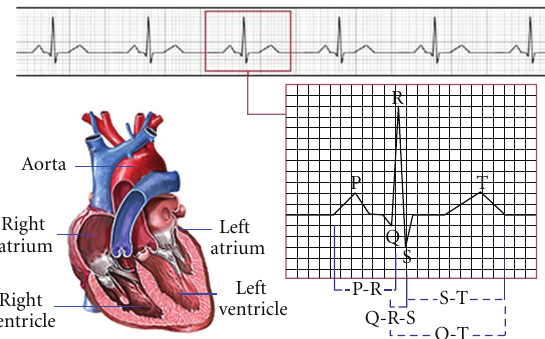
Figure 3: Shows the structure diagram of the normal human heart from an anterior view. In the heart, a ventricle is one of two large chambers that collect and expel blood received from an atrium towards the peripheral beds within the body and lungs. The atrium (an adjacent/upper heart chamber that is smaller than a ventricle) primes the pump.